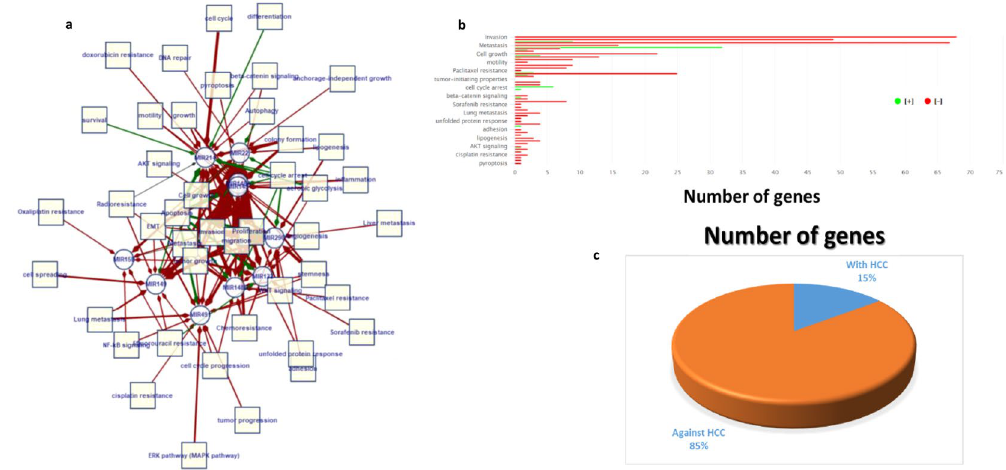
Figure 1. HCC pathogenetic network of the selected HCSC down-regulated miRNAs. ( a ) Network and ( b ) chart are created by miROB online database. Arrows and bars in red indicate the negative effect of the miRNA on the targeted biological process, while green arrows show the positive effect. ( c ) The graph indicates the number of miRNA target genes to promote (with HCC) and to suppress (against HCC)